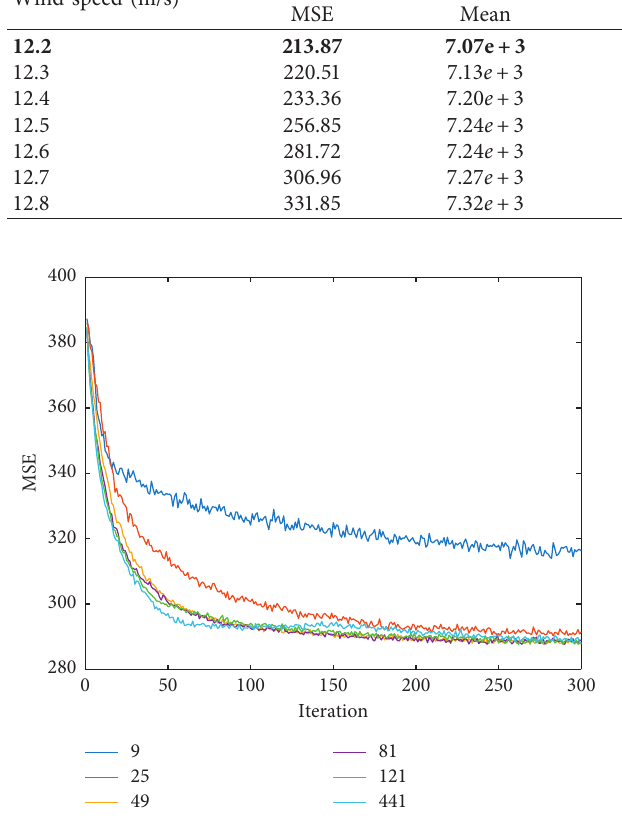
Figure 10: Evolution of the MSE with different number of